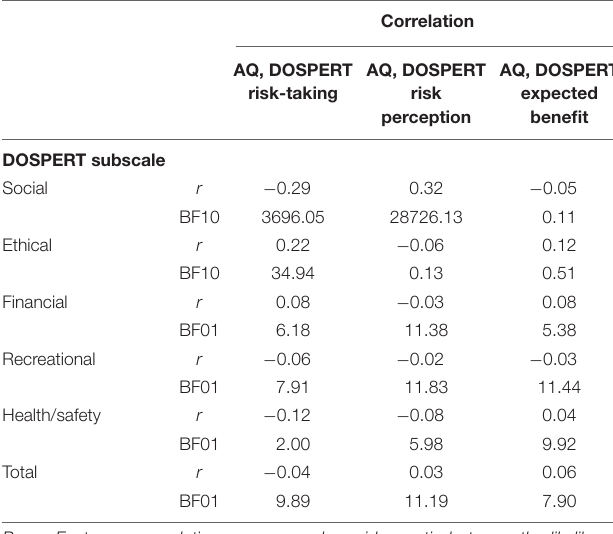
TABLE 1 | Correlations between autistic traits (AQ) and the three DOSPERT scales for each subscale of the DOSPERT separately.